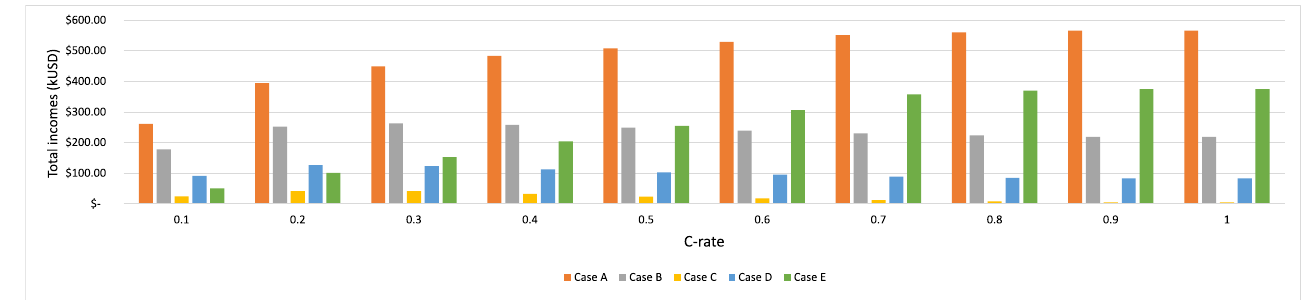
Figure 8. Total BESS income results for each case study.